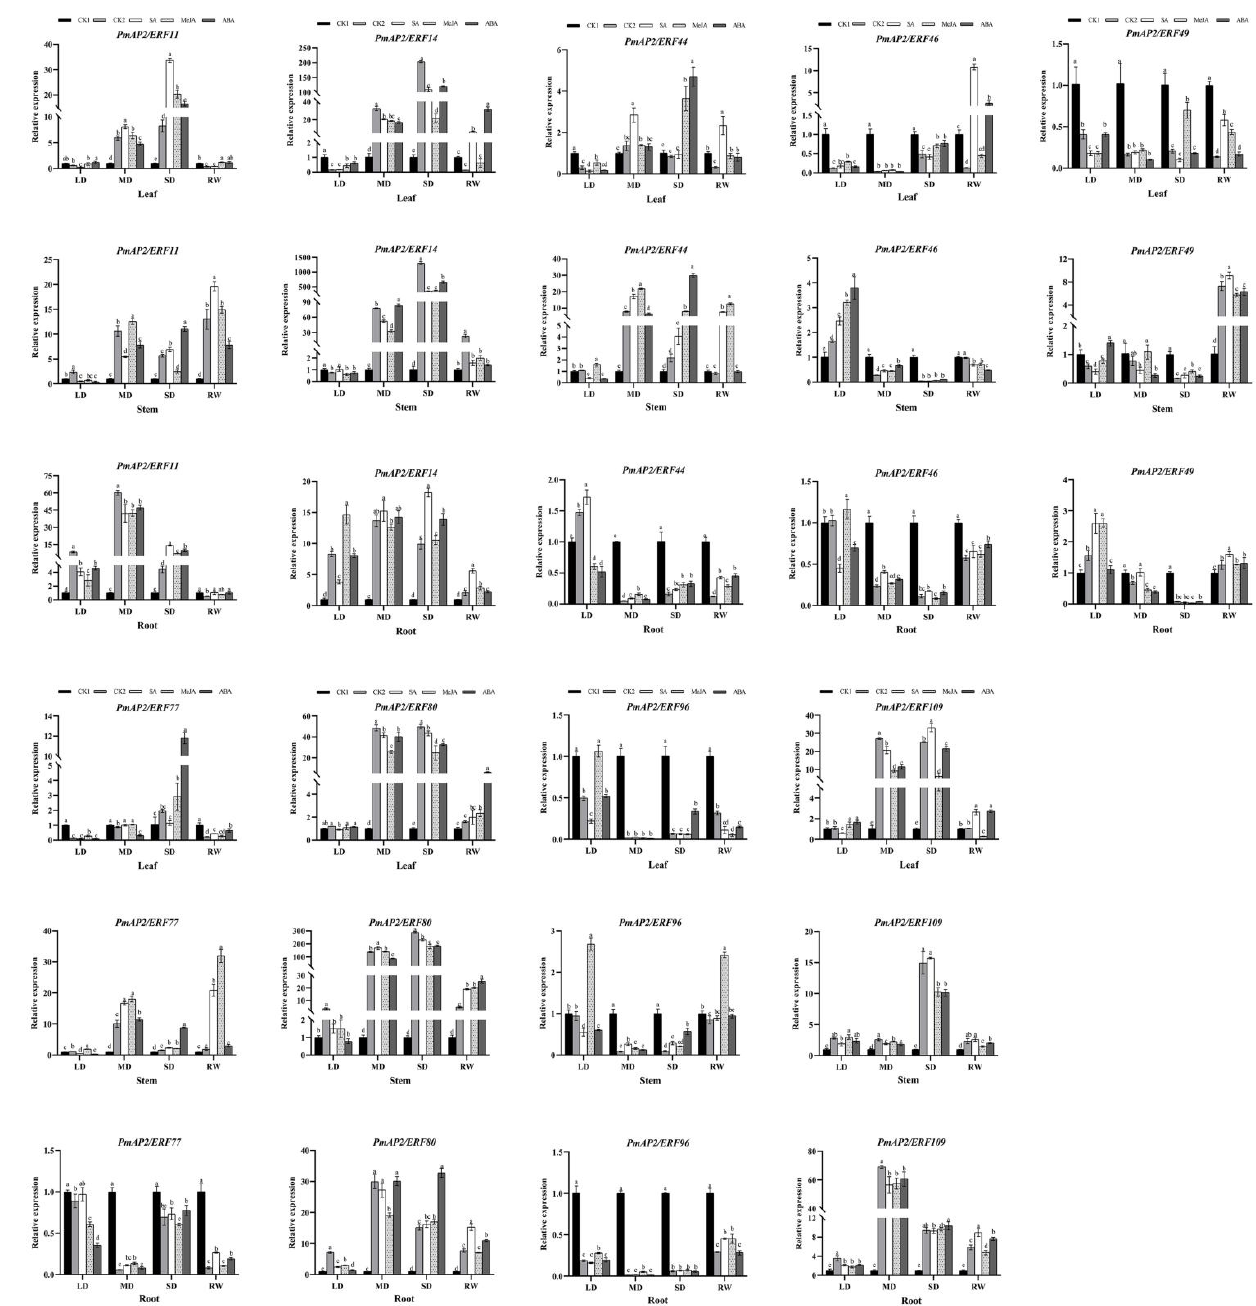
Figure 8. Expression patterns of PmAP2/ERF genes in drought-resistant lines during drought stress. LD indicates mild drought, MD indicates moderate drought, SD indicates severe drought, and RW indicates rehydration. Different lowercase letters indicate differences in gene expression at the p < 0.05 level between treatments at each sampling site. The standard error of the mean for three biological replicates is represented by the error bars.